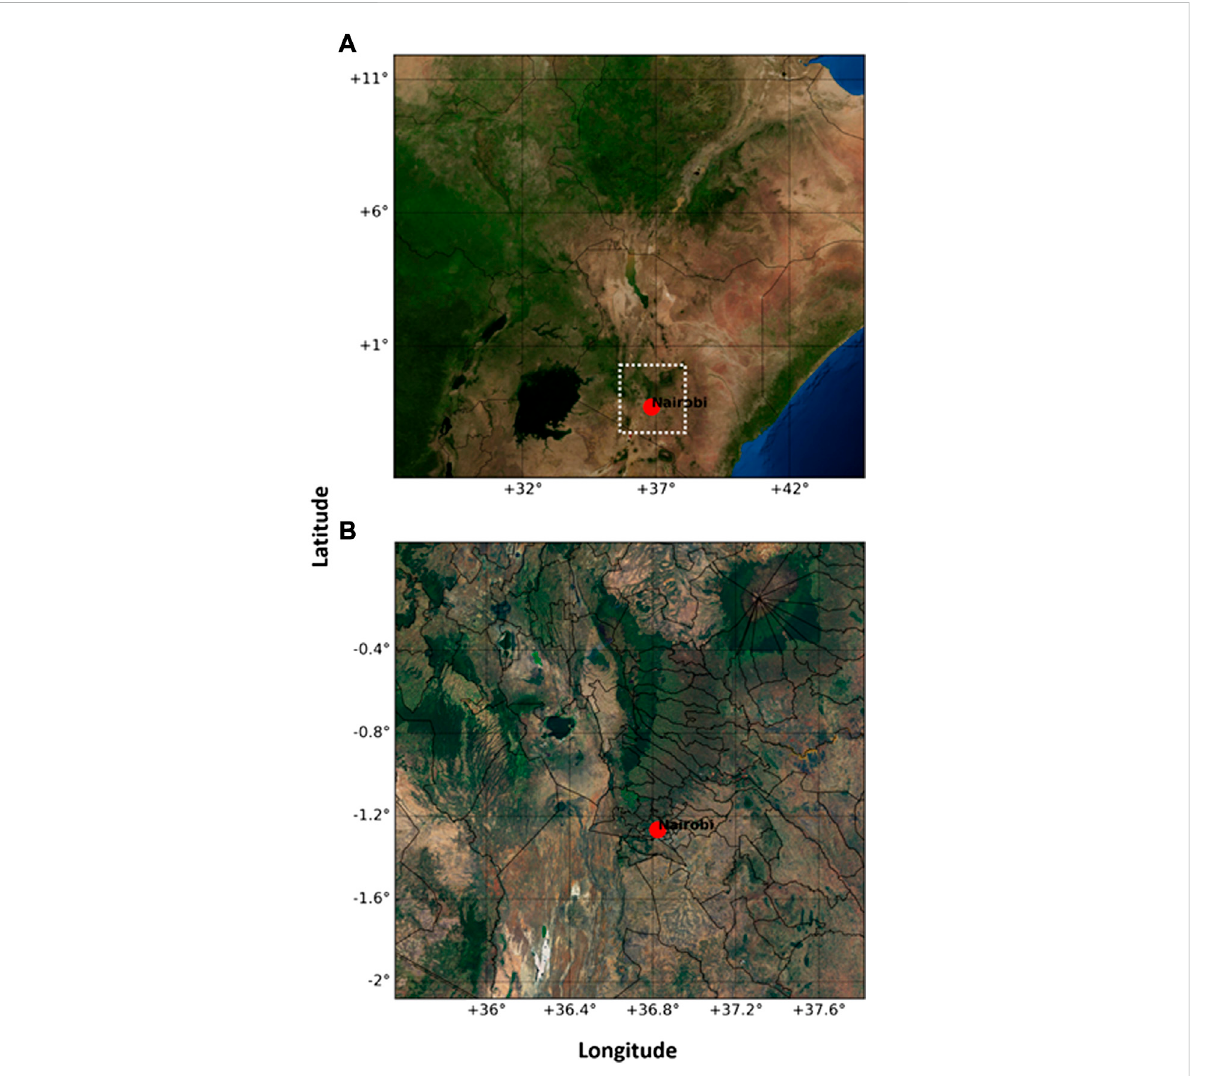
FIGURE 2 Geographical domain of (A) East Africa and (B) Kenya, with spatial resolution of 18 km × 18 km and 2 km × 2 km, respectively used for the quantitative analysis of the ECLIPSE emissions. Topography relief generated from ArcGIS 2021